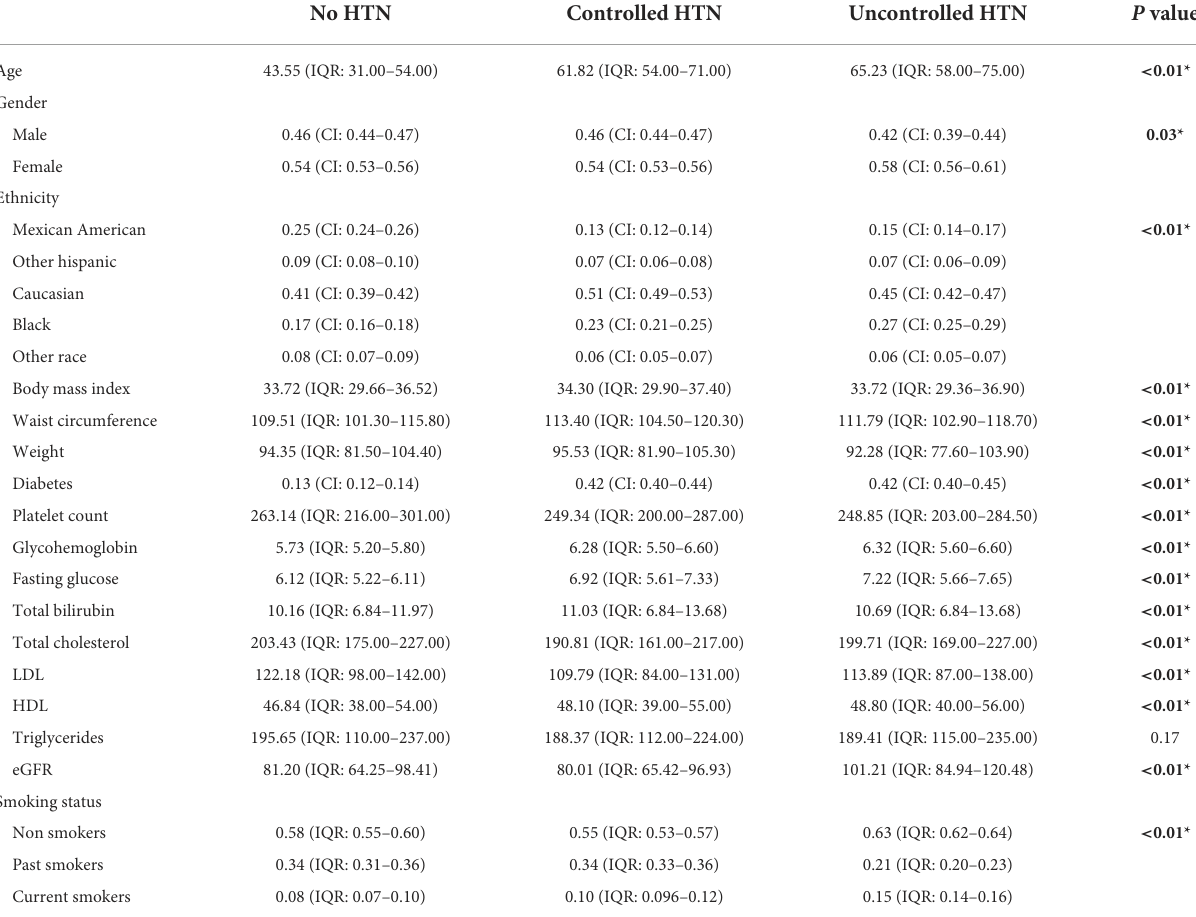
TABLE 2 Comparisons between non hypertensive, controlled and uncontrolled HTN in